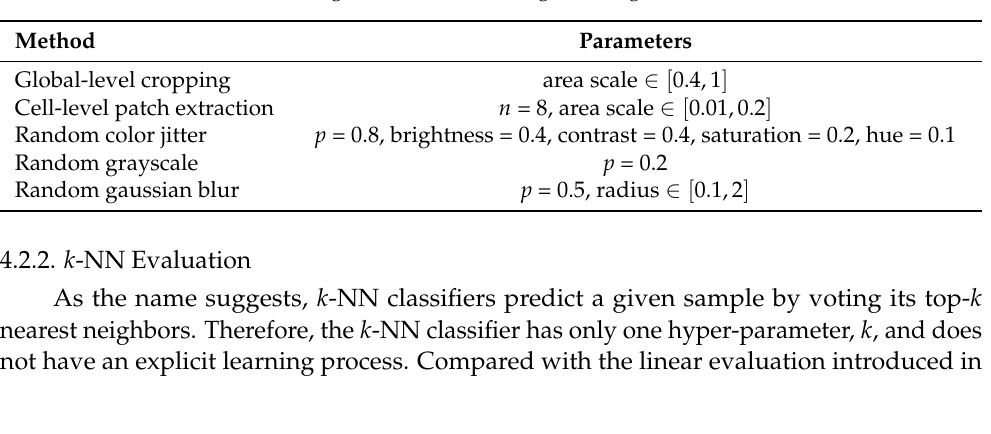
Table 4. Details of the random augmentations used to generate global-level and cell-level